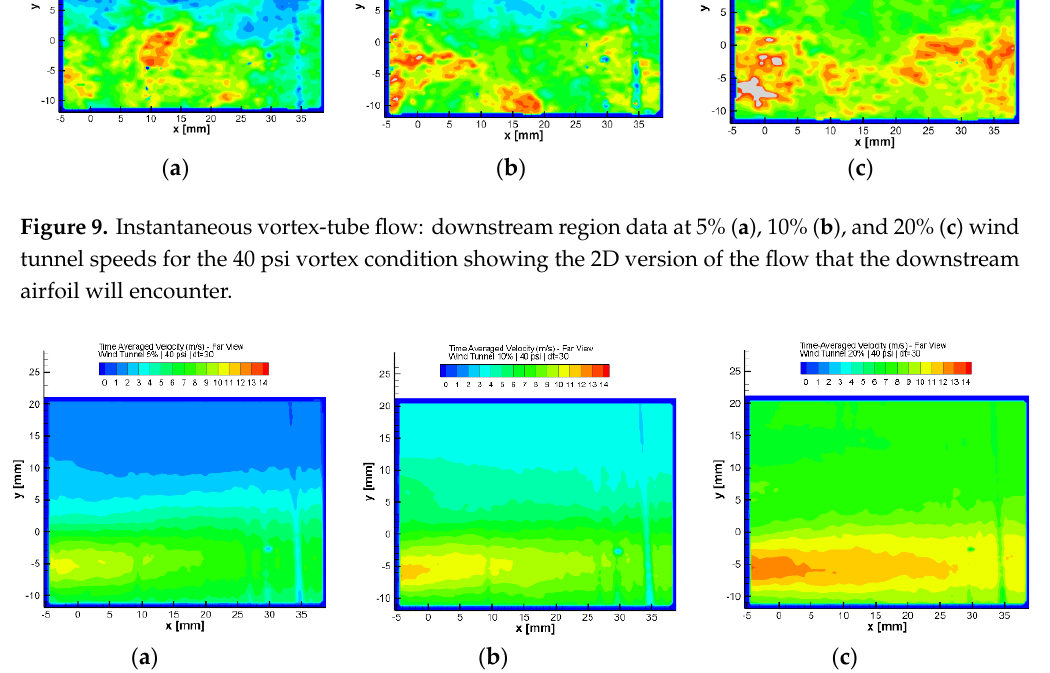
Figure 10. Average vortex-tube flow: downstream region data at 5% ( a ), 10% ( b ), and 20% ( c ) wind tunnel speeds for the 40 psi vortex condition showing the 2D version of the flow that the downstream airfoil will encounter.